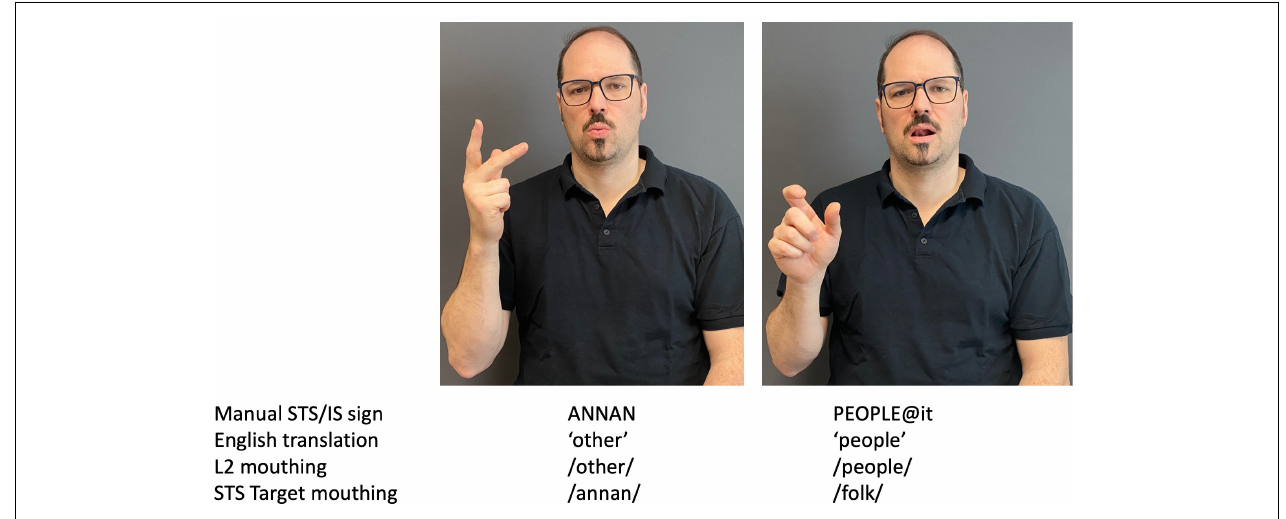
FIGURE 1 | Examples of mouth